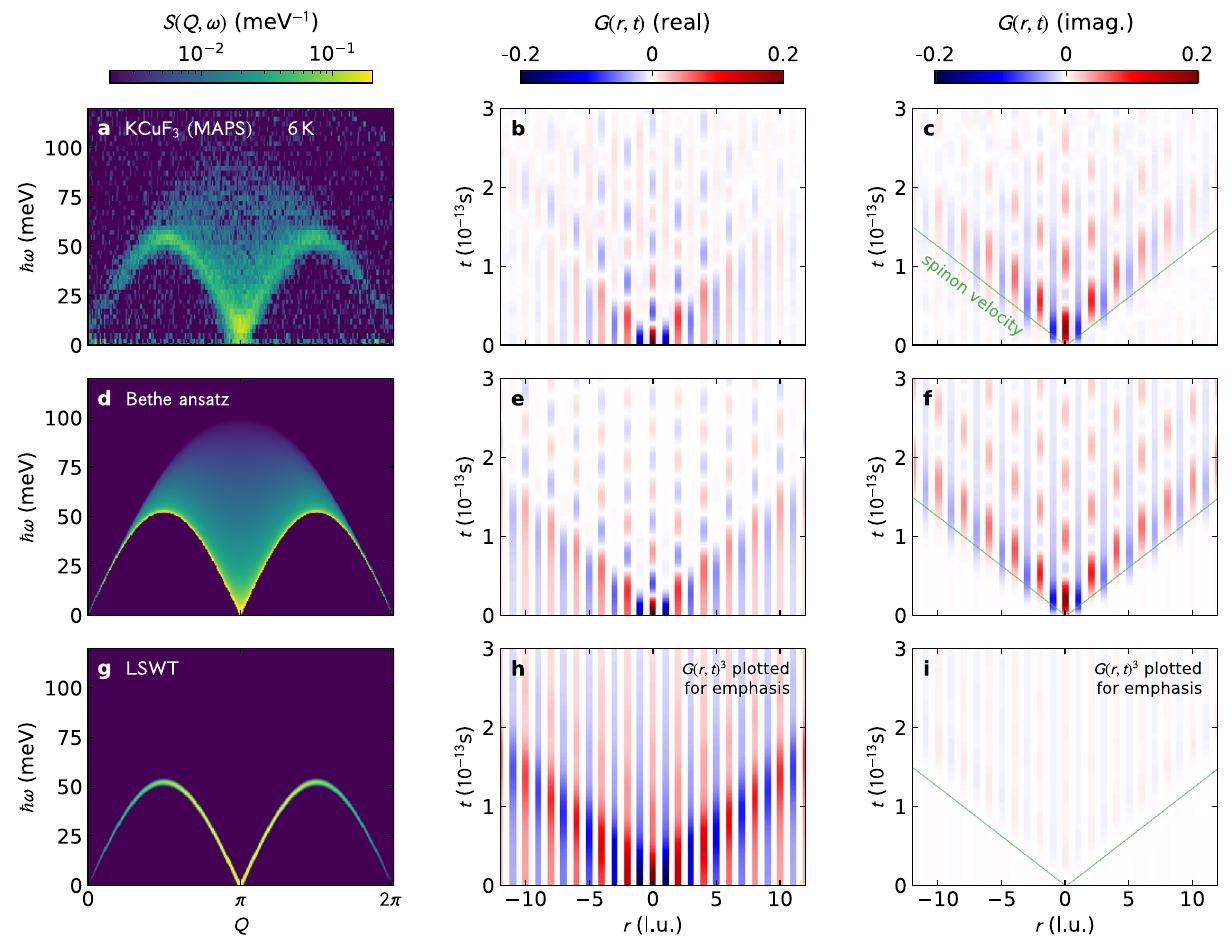
spin wave theory (LSWT)on a S =1/2 HAF chain (renormalized by π /2 to matchthe light cone velocity in the top twopanels).The thingreen lines on G ( r , t )plots show the magnon/spinon